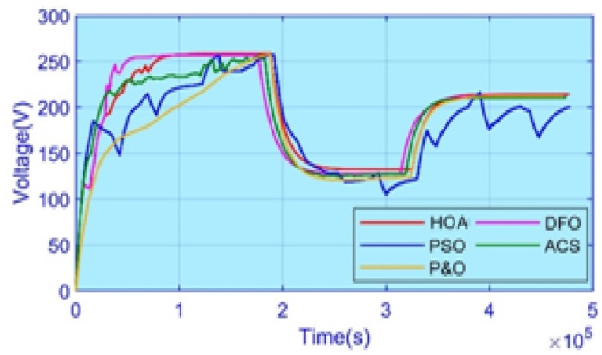
Figure 14. Comparison of HOA voltage for Case 1 .